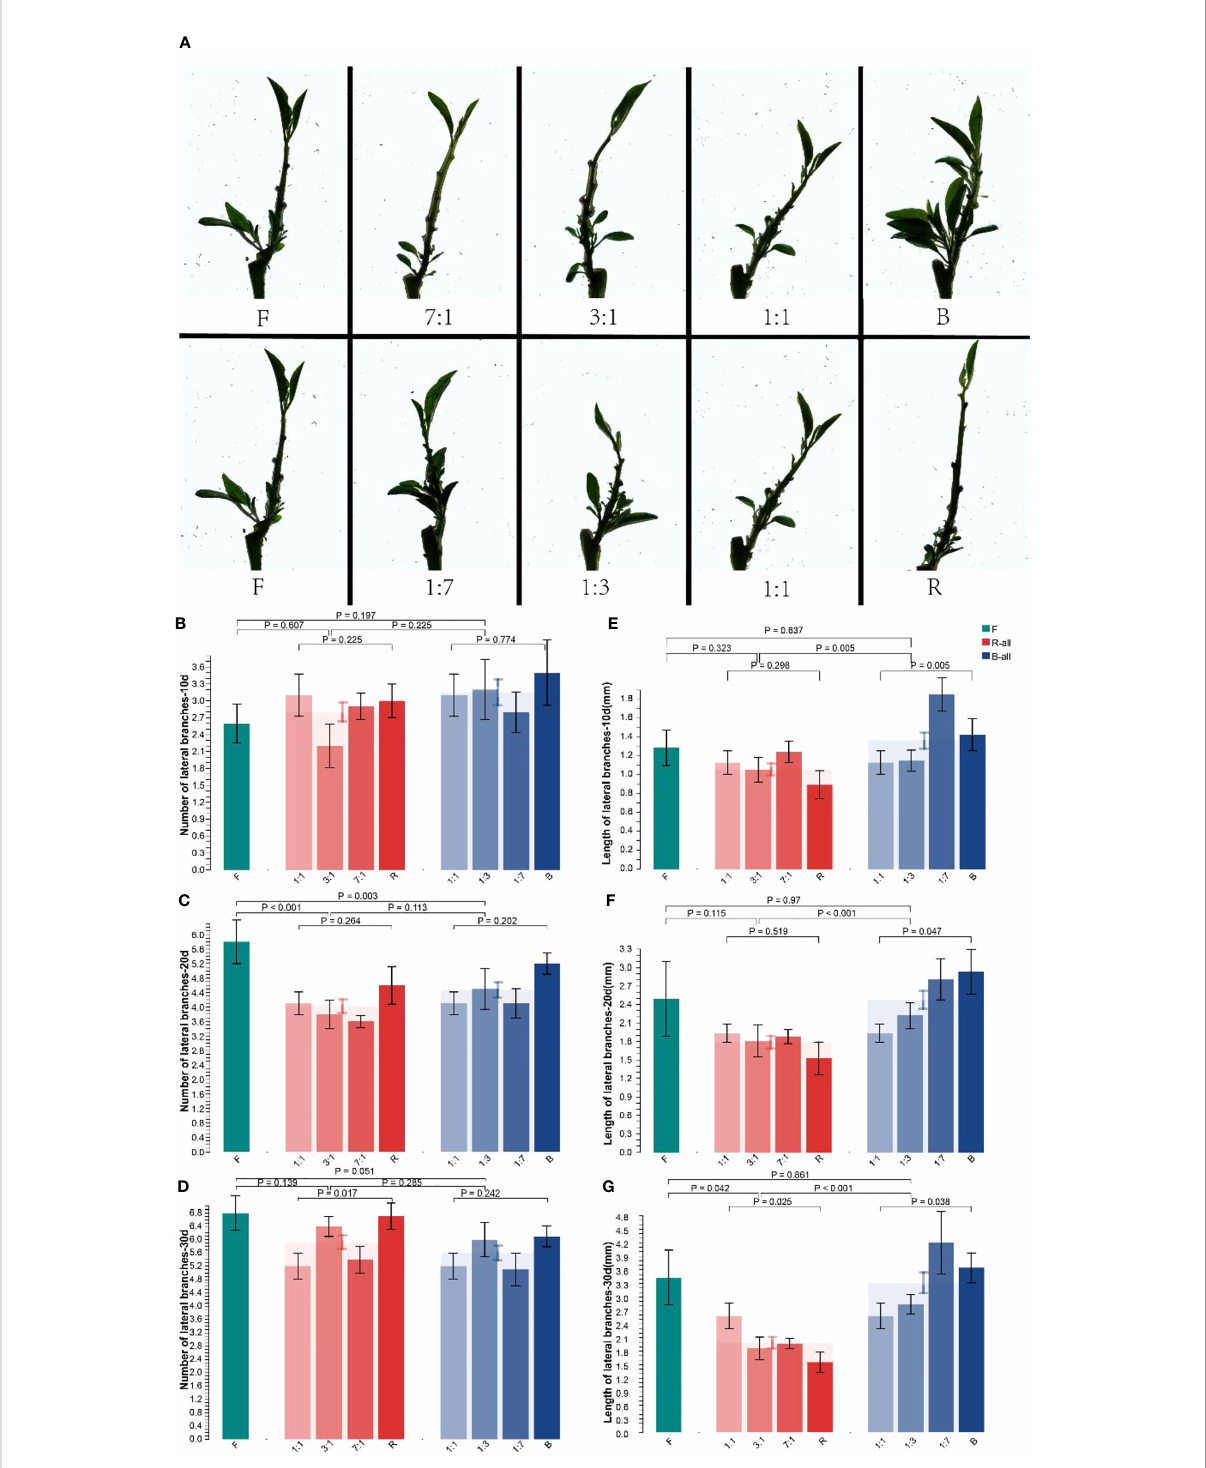
FIGURE 3 Effect of different light conditions on the lateral branching of Pepino seedlings. (A) seedling phenotype of Pepino under different light treatments; (B) number of lateral branches of seedlings of Pepino under different light treatments for 10 d; (C) number of lateral branches of seedlings of Pepino under different light treatments for 20 d; (D) number of lateral branches of seedlings of Pepino under different light treatments for 30 d; (E) length of lateral branches of Pepino under different light treatments for 10 d; (F) length of lateral branches of Pepino under different light treatments for 20 d; (G) length of lateral branches of Pepino under different light treatments for 30